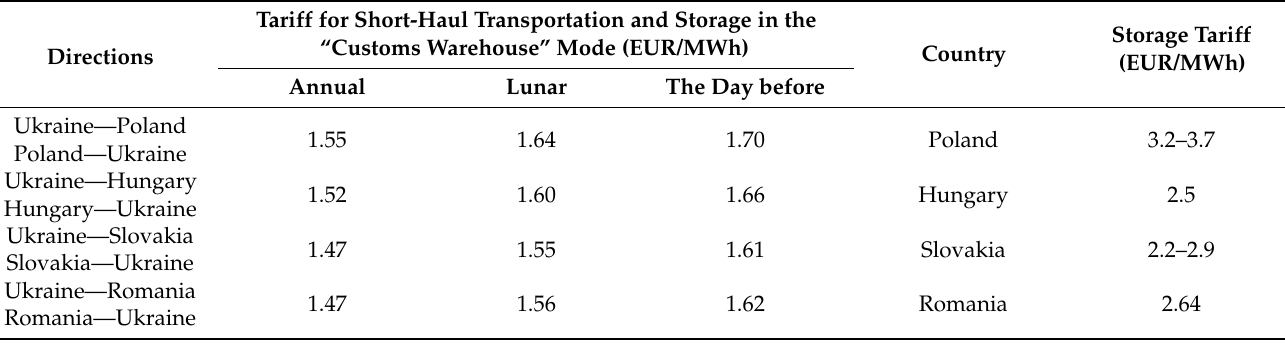
Table 7. Comparison of gas storage tariffs in Ukraine and nearby EU